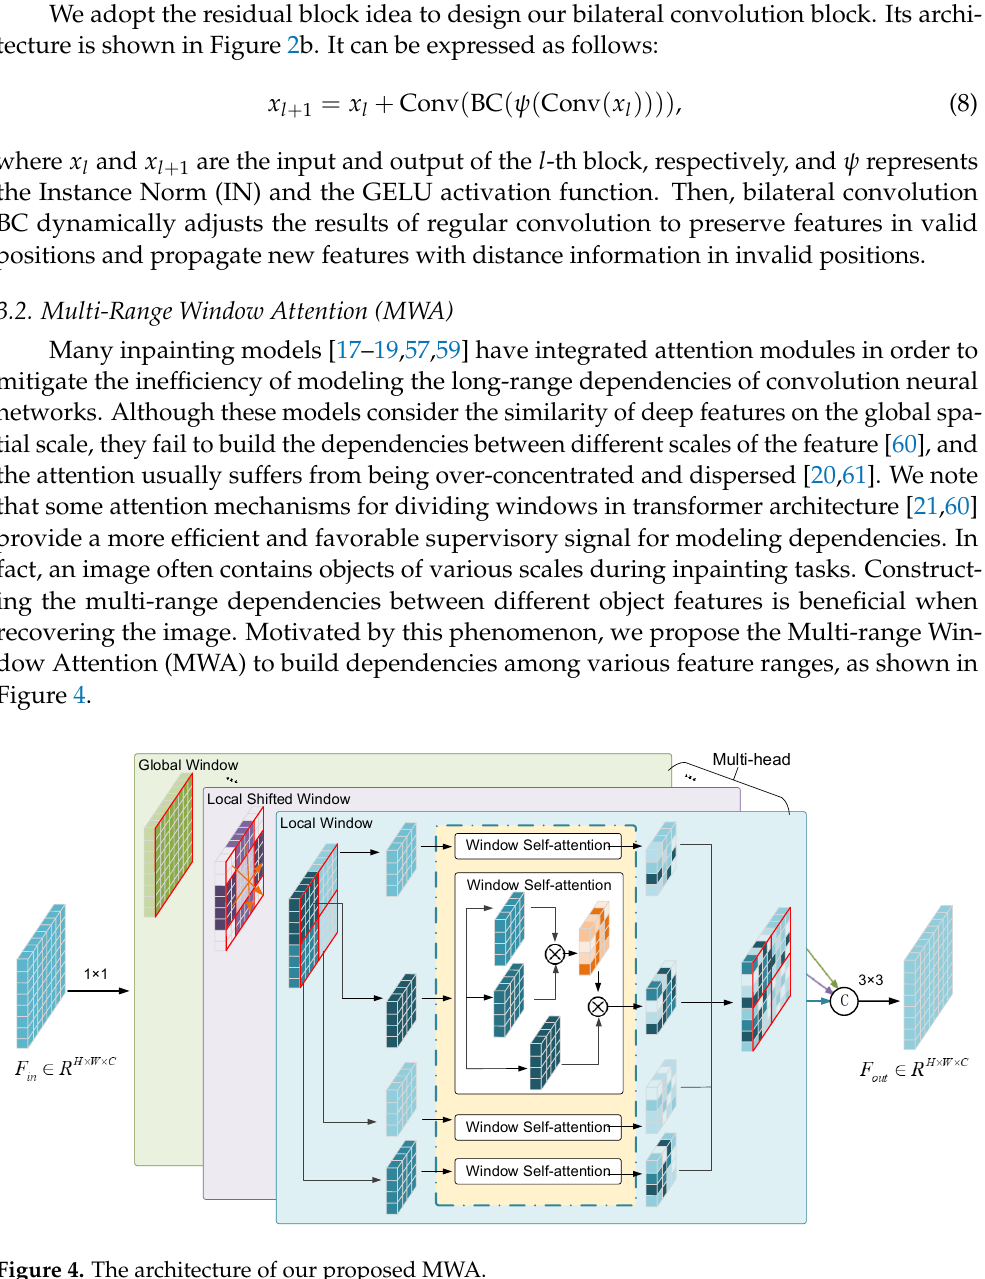
Figure 4. The architecture of our proposed